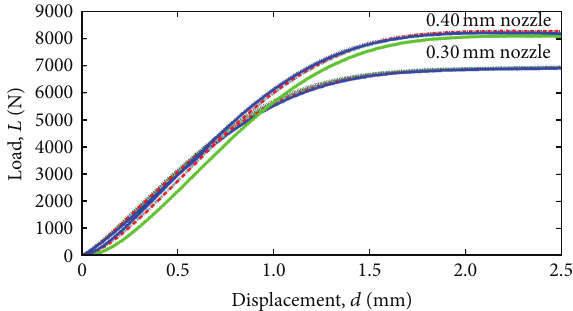
Figure6:ComparisonofthecompressiontestofPC-ISOcylindrical test specimens, printed with 0.30 mm and 0.40 nozzle configuration.